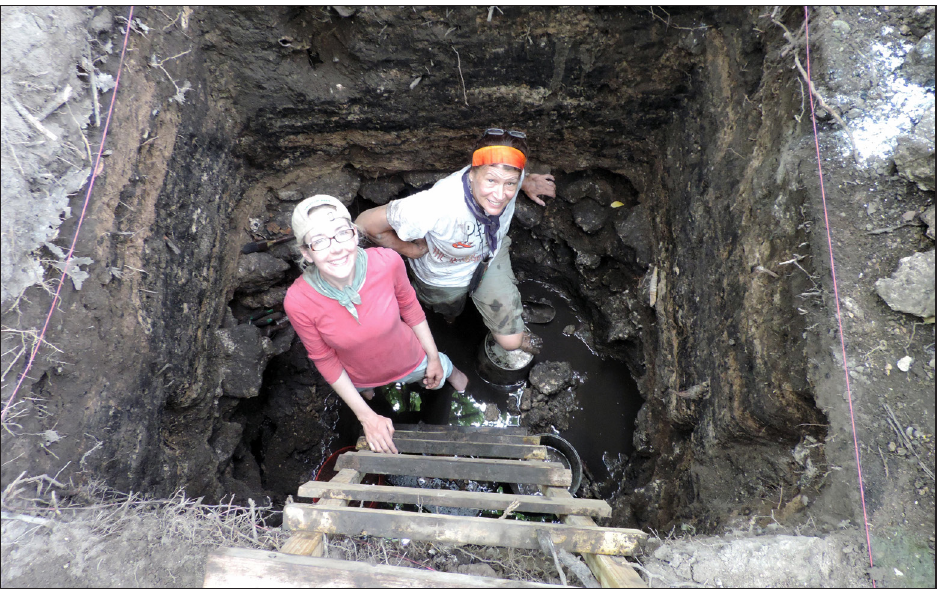
Figure 3: Lindsay (foreground) and Liz in Op 13-1 test pit. Photo looks N (Photo Marco Gonzalez